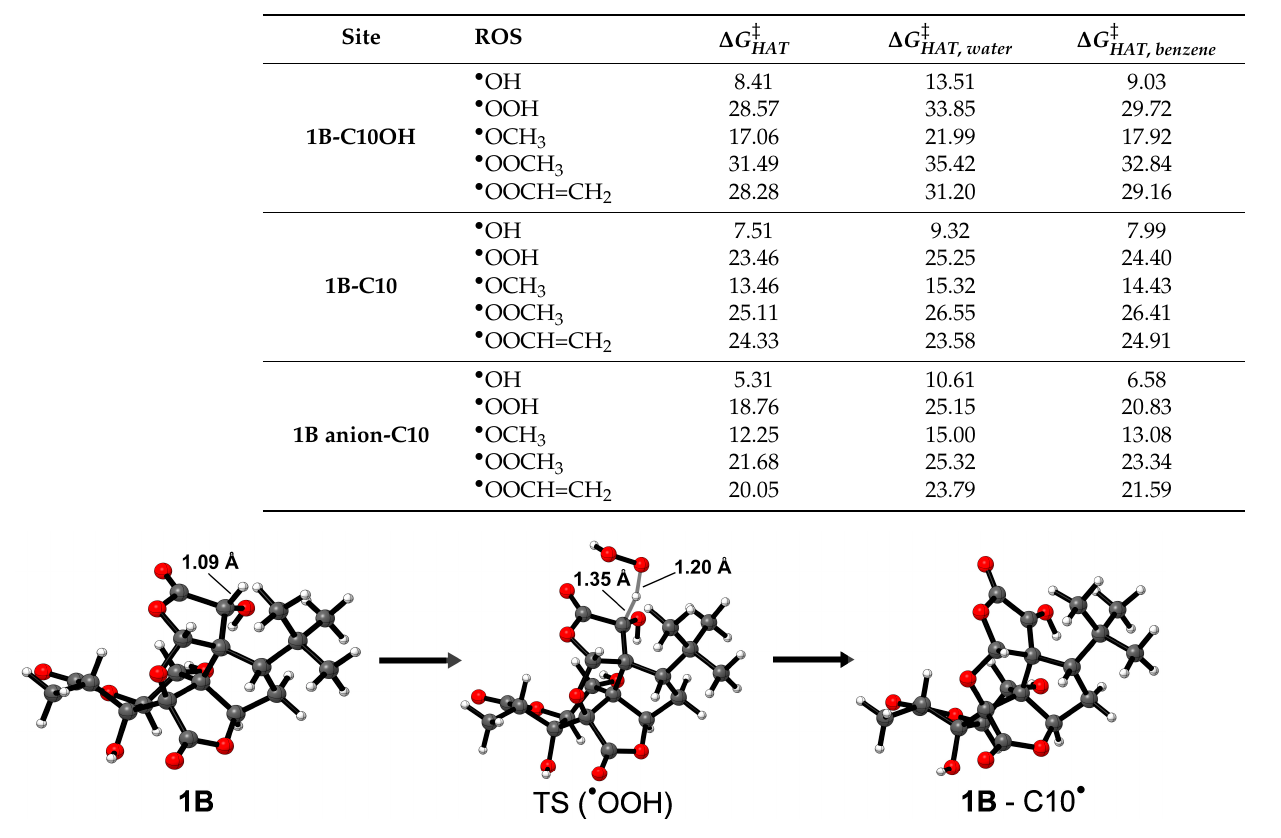
Table 3. Gibbs free activation energies ( ∆𝐺 (cid:3009)(cid:3002)(cid:3021)‡ kcal mol − 1 ) computed in gas phase, water and ben- zene of 1B and the 1B anion for the scavenging of • OH, • OOH, • OCH 3 , • OOCH 3 and • OOCH=CH 2 via HAT from C10 and C10OH. Level of theory: (SMD)-M06-2X/6-311+G(d,p)//M06-2X/6-31G(d).